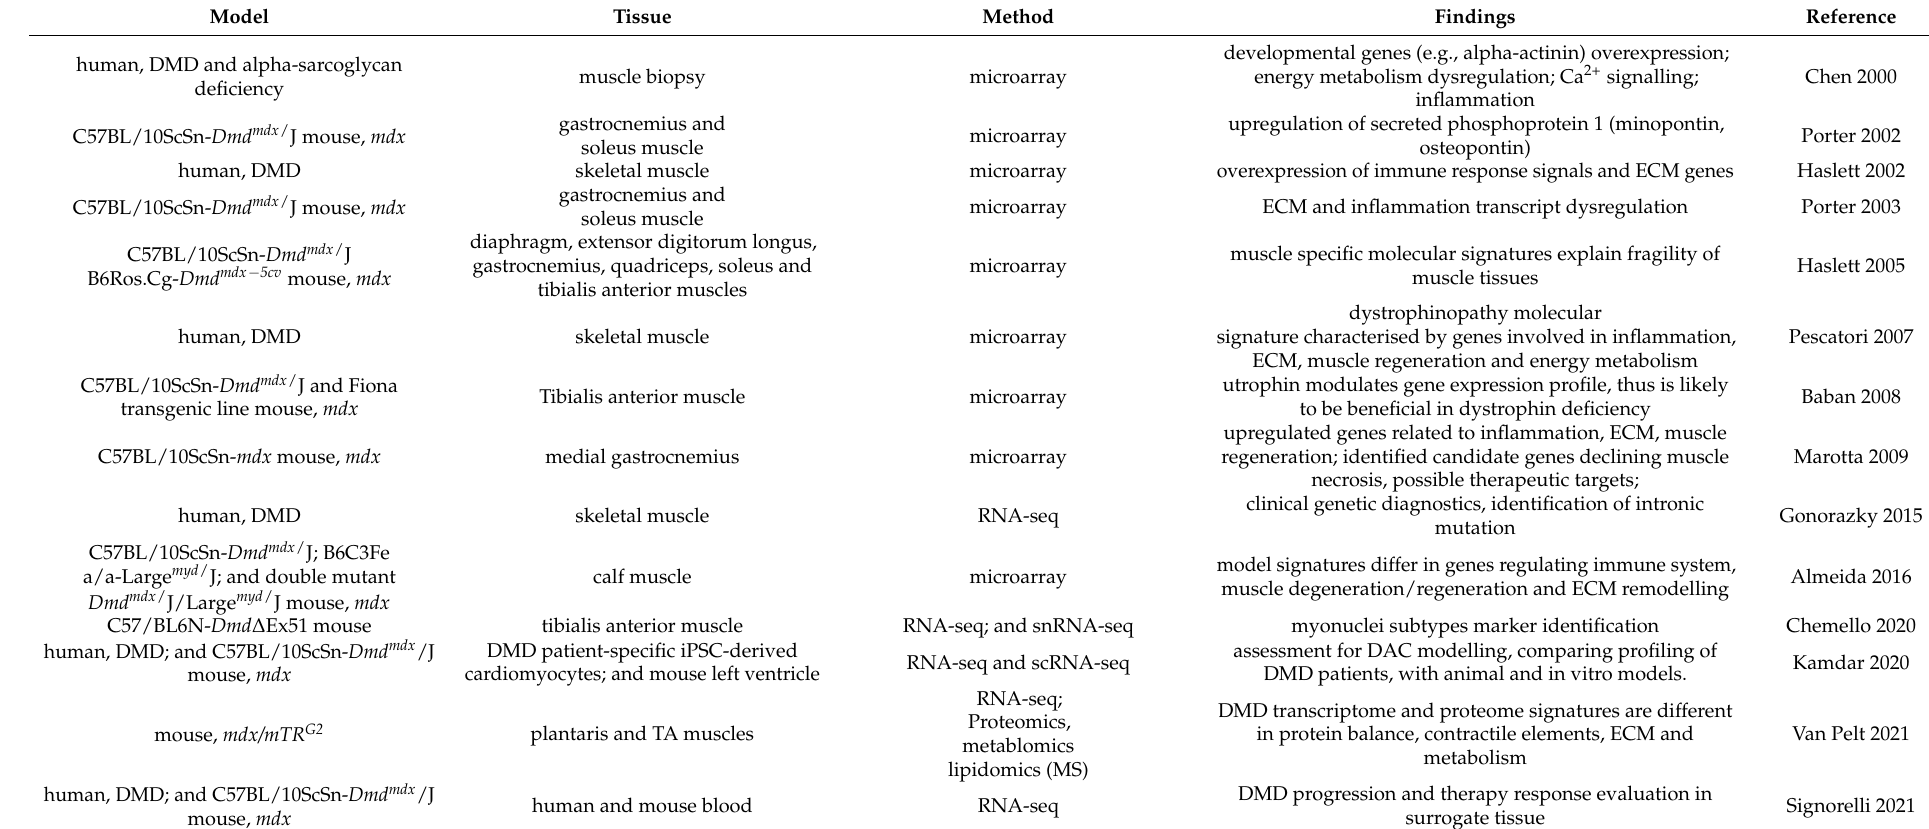
Table 2. The main studies performed on dystrophin deficient models using transcriptomic approaches. DAC, Dystrophin-associated cardiomyopathy; DMD, Duchenne muscular dystrophy; ECM, extracellular matrix; iPSC, induced pluripotent stem cells; MS, mass spectrometry; RNA-seq, RNA-sequencing; snRNA-seq, single-nuclei RNA-sequencing; scRNA-seq, single-cell